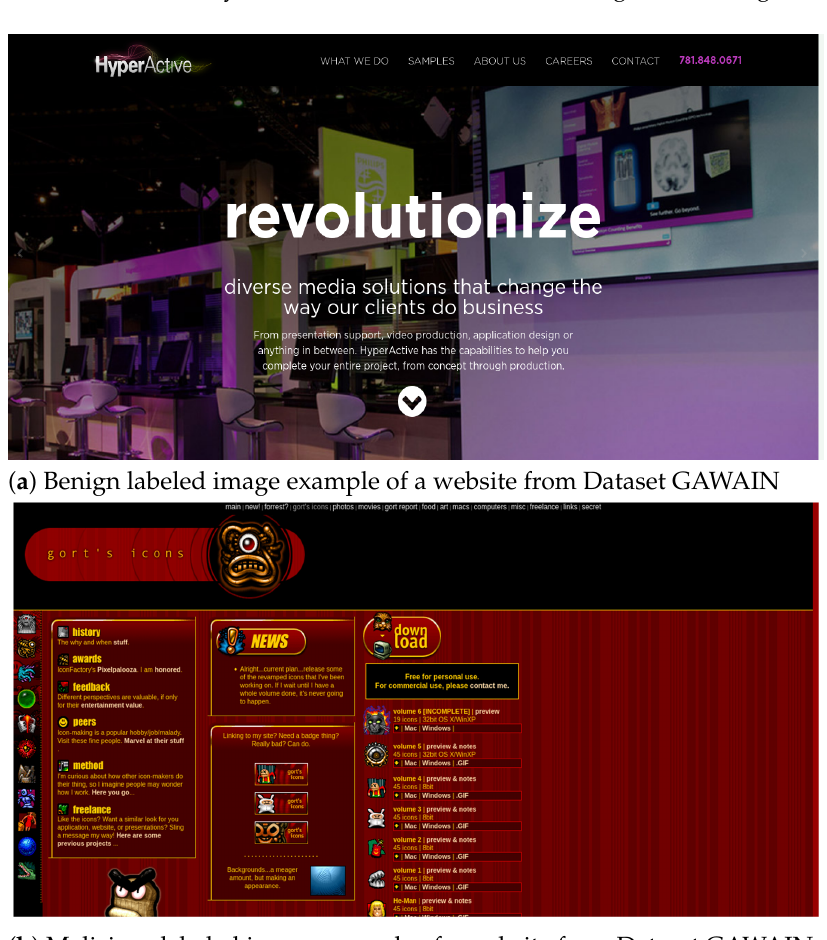
Figure 2. Examples of two website